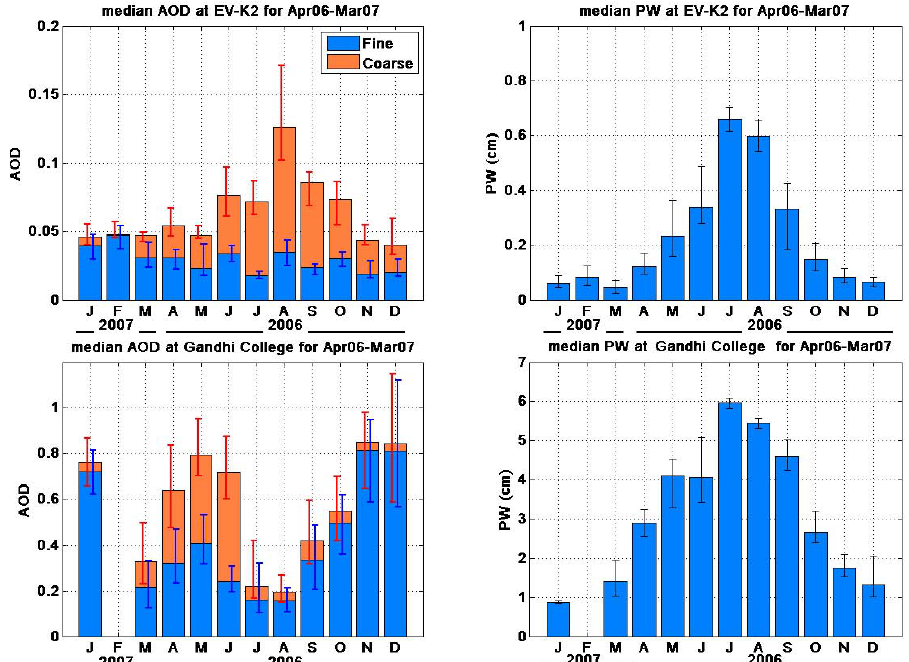
Fig. 4. Monthly median sunphotometer observations collected in the period April 2006-March 2007 at Ev-K2-CNR (top row) and Ghandi College (bottom row). L1.5, cloud-screened 500nm AOD, and contribution of fine-mode particles, AOD FM (blue element of bars) are plotted in the left column, while precipitable water (PW) plots are in the right column. Thin lines span the 25th–75th percentile